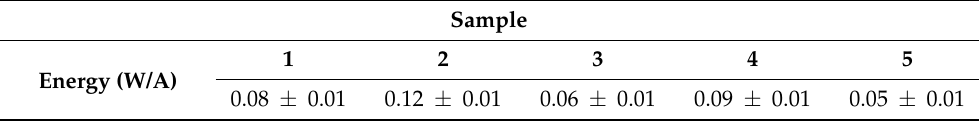
Figure 9. Hydrophilicity measurement; (1) drop on the specimens, (2) substrate of coating, (3,4) con- vex double lenses, (5) Guppy CMOS camera for detecting, and (6) software system. Figure 10 shows the average angles between a drop of water and spin-coated samples on the solid film. The average angle values (θ Young ) ranged from 52.81° to 62.67° and the lowest angle belonged to spin-coated sample 2 on the film. The good wetting can be re- ported based on θ < 90 ° for all samples [65]. It is proved that sample 2 has a better agree- ment with the liquid than the other samples and has the highest surface energy [66,67]. The result indicates that the surface of spin-coated sample 2 has the highest polarity and the highest uniformity on the solid film.